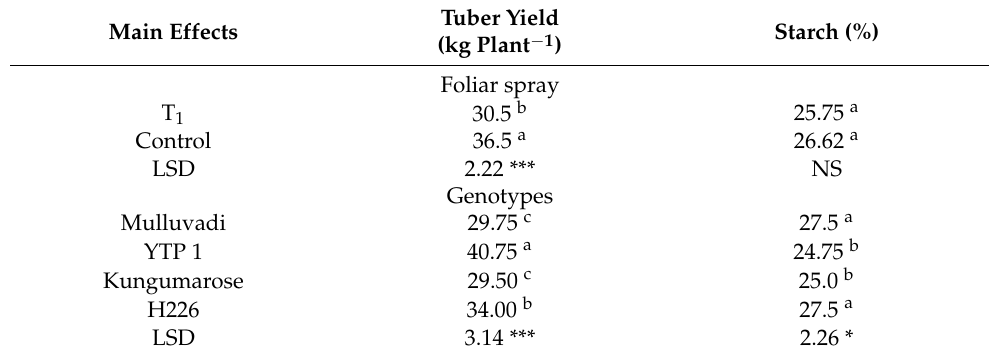
Table 6. Main effects of combined nutrient/biocontrol agent mixture foliar spray and genotypes on tuber yield (kg) and starch (%) of cassava. The data presented are the mean of two seasons ( n = 10). Means followed by the same letter are not statistically significant at p <